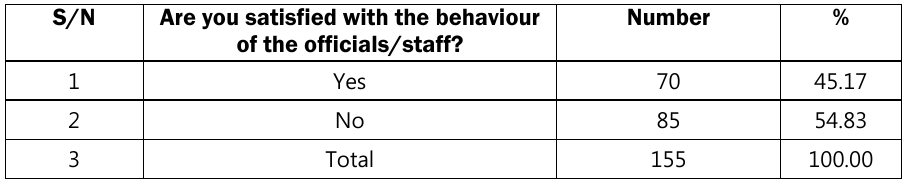
TABLE 3: Citizens level of satisfaction with the behaviour of the officials/staff S/N Are you satisfied with the behaviour